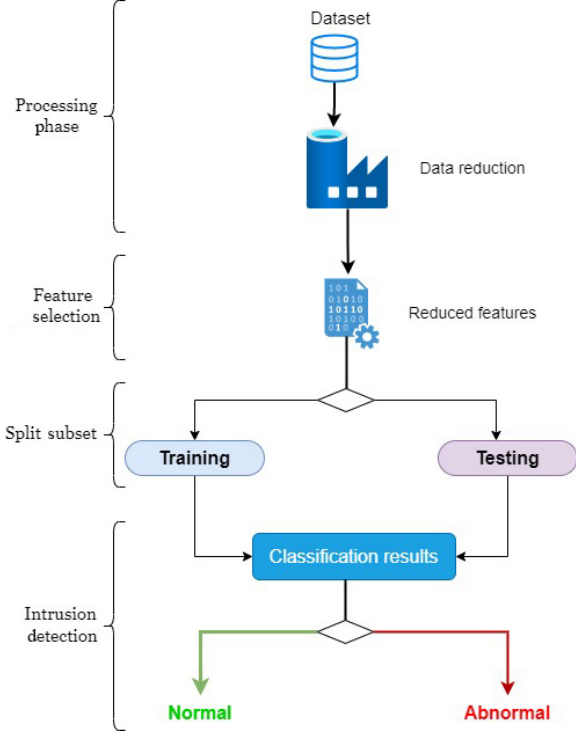
Fig. 2 Proposed model architecture. normal or abnormal activities. The RF